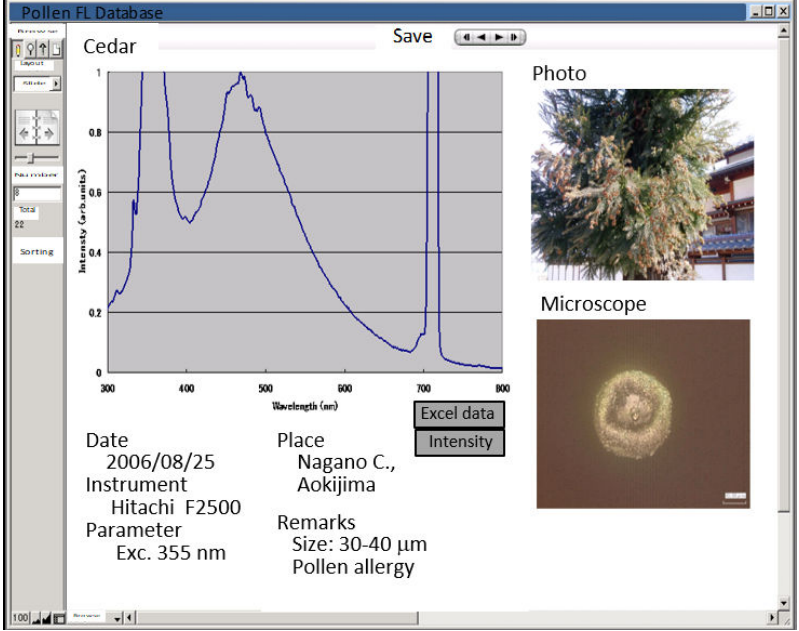
Figure 2. Display image of fluorescence database which includes information such as pollen name, images, experiment conditions (measurement system, date, place etc.), and comments. Headings are in